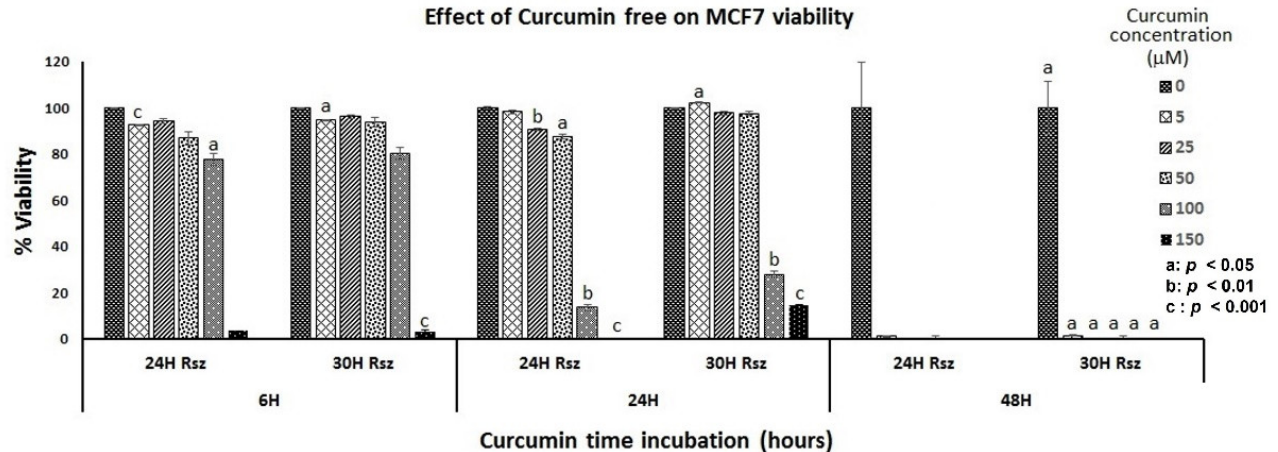
Figure 11. Viability percentage of MCF7 cells in the presence of free curcumin: 15,000 MCF7 cells were treated for 6, 24 and 48 h with different concentrations of free curcumin (0, 5, 25, 50, 100 and 150 μM). The reduction in resazurin to resorufin was measured at 4, 6, 24 and 30 h.